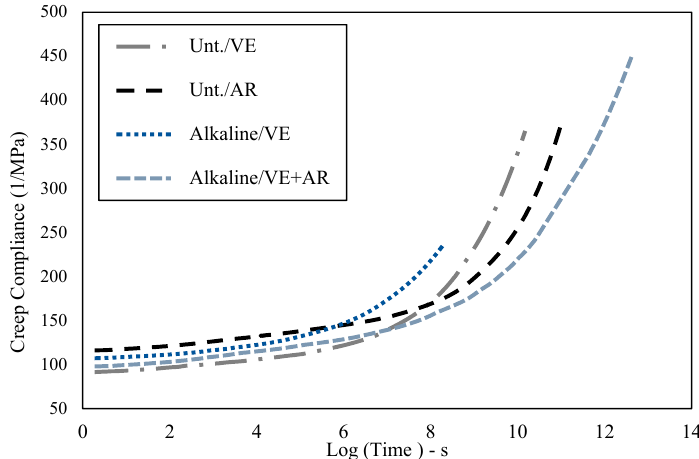
Figure 8. Creep compliance master curves for untreated and treated flax fiber with VE and VE+AR resins.